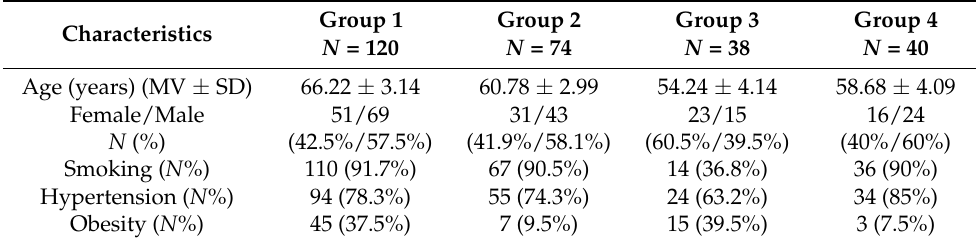
Table 1. Frequencies of specific characteristics of the